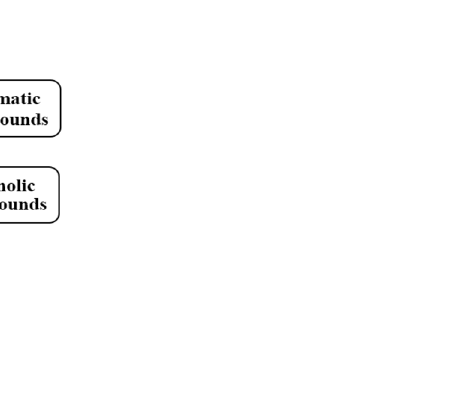
Figure 12. Proposed pathway of monosaccharide production from lignocellulosic degradation of the rice straw